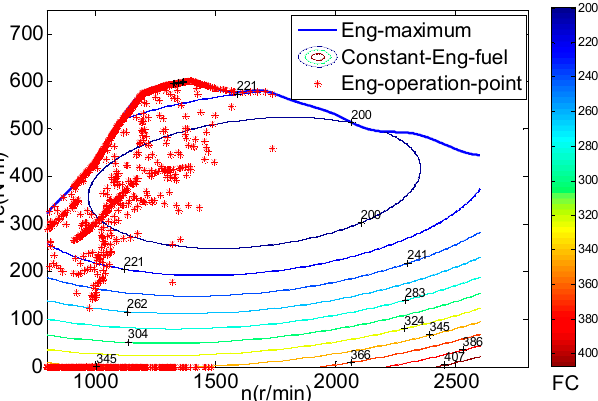
Figure 19. Distribution of the engine operating point (Rule-based).